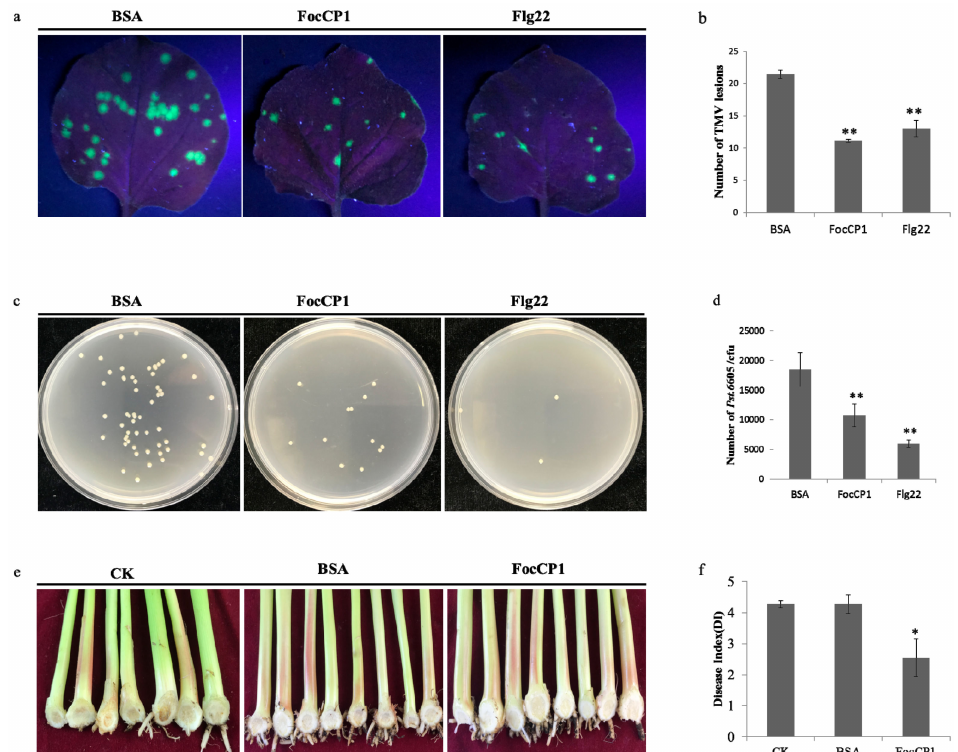
Figure 6. FocCP1 induced systemic acquired resistance in tobacco and enhanced banana seedling resistance against FOC4 infection. ( a ) Tobacco mosaic virus (TMV)-green fluorescent protein (GFP) in tobacco leaves treated by FocCP1 was observed and counted under a UV lamp; BSA and Flg22 were the negative and positive controls, respectively. ( b ) TMV-GFP incidence was calculated in tobacco leaves. TMV lesions in tobacco leaves treated by FocCP1and Flg22 were fewer and smaller than in the control leaves. ( c ) Number of Pst. 6605 in tobacco leaves treated by FocCP1 was observed on a King’s B (KB) medium plate, BSA and Flg22 were the controls. ( d ) The concentration of Pst. 6605 in tobacco leaves treated by FocCP1 and Flg22 was significantly less than in BSA treated plants. ( e ) Browning in pseudo-stem and bulb of banana plants was counted after inoculation of FOC4 with water as a blank control (CK) and BSA as a negative control. ( f ) The disease index of banana wilt caused by FOC4 after FocCP1 treatment was counted in banana plants. For ( a ) and ( b ): 10 leaves of five plants were used for replication, respectively. For ( c ) and ( d ): six leaves of tobacco plants were used for replication. For ( e ) and ( f ): nine banana plants were used for replication. In all experiments, three independent replicates were performed. Values were means ± SE. Statistical analysis of data was done using SAS (*, p < 0.05; **, p <